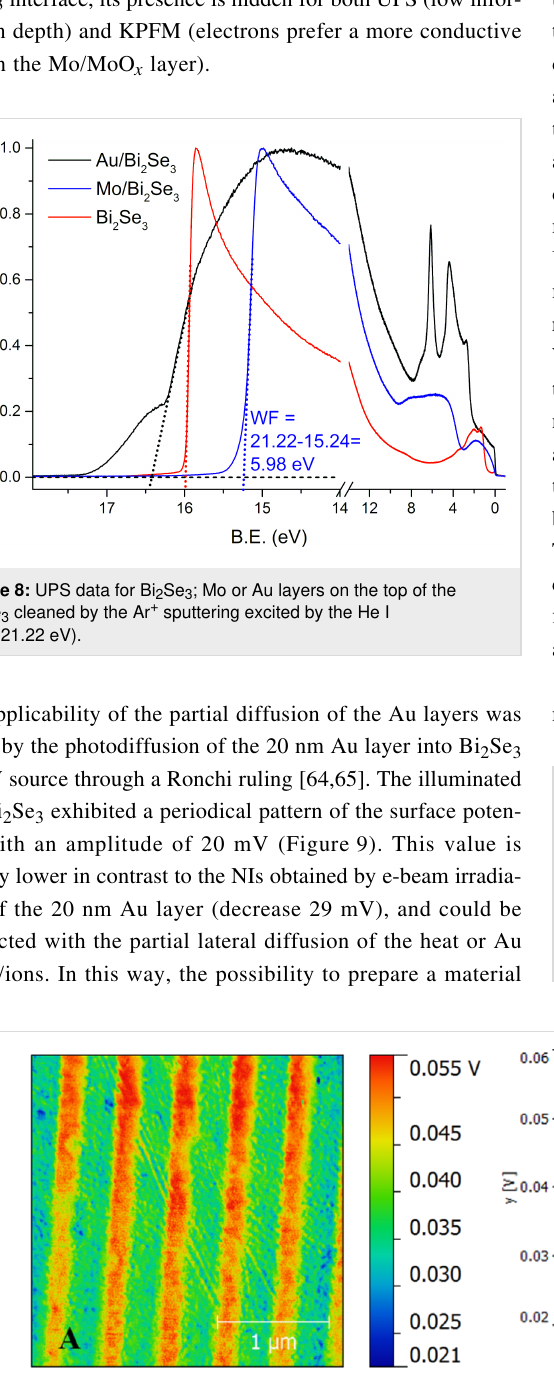
Bi 2 Se 3 substrate hinders a reaction (the sample exhibits a sand- wich structure of reactive Bi 2 Se 3 /isolating MoSe 2 /isolating Mo and MoO x /reactive oxygen-depleted MoO x ). This is further re- flected in a low contrast in KPFM measurements, as only non- irradiated and re-oxidized (due to ambient atmosphere) MoO x layers are measured. Even if MoSe 2 is formed at the MoO x / Bi 2 Se 3 interface, its presence is hidden for both UPS (low infor- mation depth) and KPFM (electrons prefer a more conductive path in the Mo/MoO x layer).